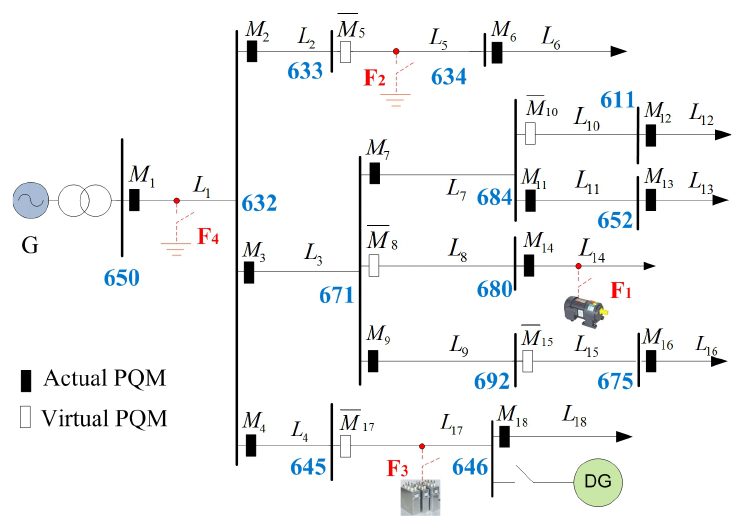
Figure 14. IEEE 13 node test feeder with DG integration.